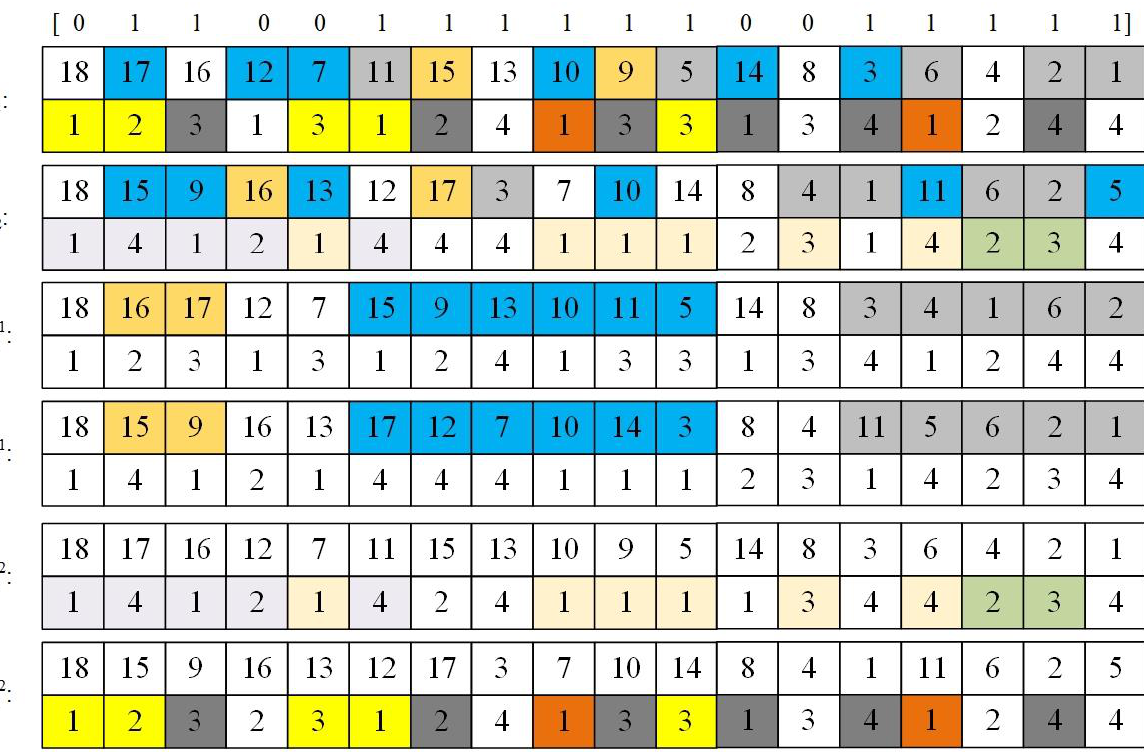
Figure 5. The offspring individuals obtained by applying the above-mentioned multi-child crossover method based on crossed row vectors.